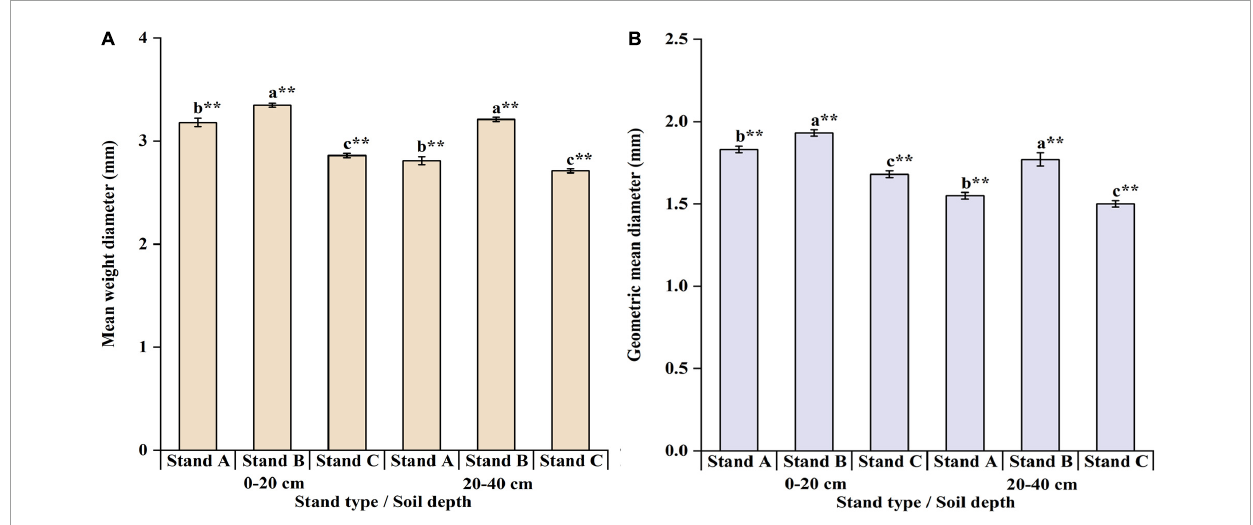
FIGURE3 Distribution of mean weight diameter (A) and geometric mean diameter (B) in Chinese fir plantations with different stand types.